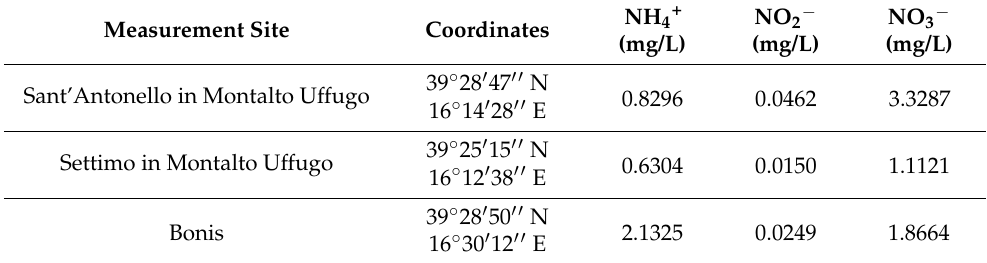
Table 3. Mean concentrations of NH 4+ , NO 2 − and NO 3 − detected in the three sampling sites. Measurement